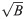
Short-term facilitation increases memory retention.A Illustration of the effects of diffusion (top) and additional drift (bottom) on the temporal evolution of distributions of initial positions p(start) towards distributions of final positions p(end) over 6.5s of delay activity. The bump is always represented by its center position φ. Two peaks in the distribution of initial positions φ(0) and their corresponding final positions φ(6.5) are highlighted by colors (purple, red), together with example trajectories of the center positions. Top: Diffusion symmetrically widens the initial distribution. Bottom: Strong drift towards one single fixed point of bump centers (φ = 0) makes the origin of trajectories indistinguishable. B Normalized mutual information (MI, see text for details) of distributions of initial and final bump center positions in working memory networks for different STP parameters and heterogeneity parameters(blue: strong facilitation, see legend in panel D). Dots and triangles are average MI (18–20 realizations, error bars show 95% CI) obtained from spiking network simulations. Lines show average MI calculated from Langevin dynamics for the same networks, repetitions and realizations (see text, shaded area shows 95% CI). Heterogeneity parameters are σL (triangles, in units of mV) and 1 − p (circles), where p is the connection probability. C Expected displacement |Δφ|(1s) for the same networks as in panel B. Dashed lines indicate displacement induced by diffusion only (B), solid lines show the total displacement (including displacement due to drift, calculated as the expected field magnitude 〈A2〉frozen). D Same as panel B, with x-axis showing the expected field magnitude. E Same as panel B, with x-axis showing the expected displacement. In panels B-D, all STP parameters except U were kept constant at τu = 650ms, τx = 150ms.